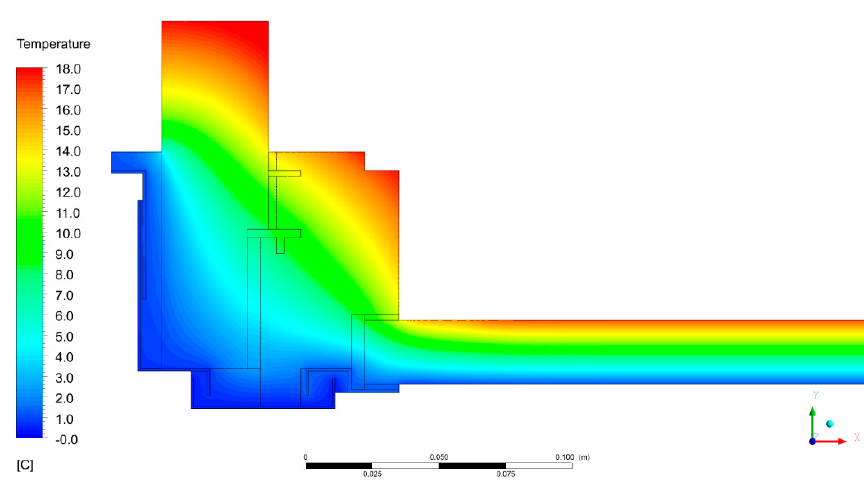
Figure 4. Temperature distribution on wooden frame, example I4 from ISO 10077-2.